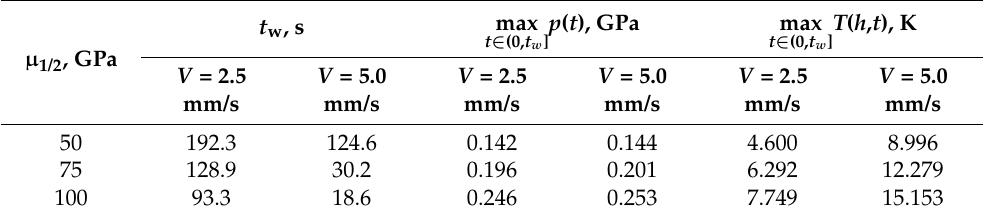
Table 2. Values of main contact characteristics depending on shear modulus in the middle of coating µ 1/2 and sliding velocity V in case of parabolic variation of the shear modulus